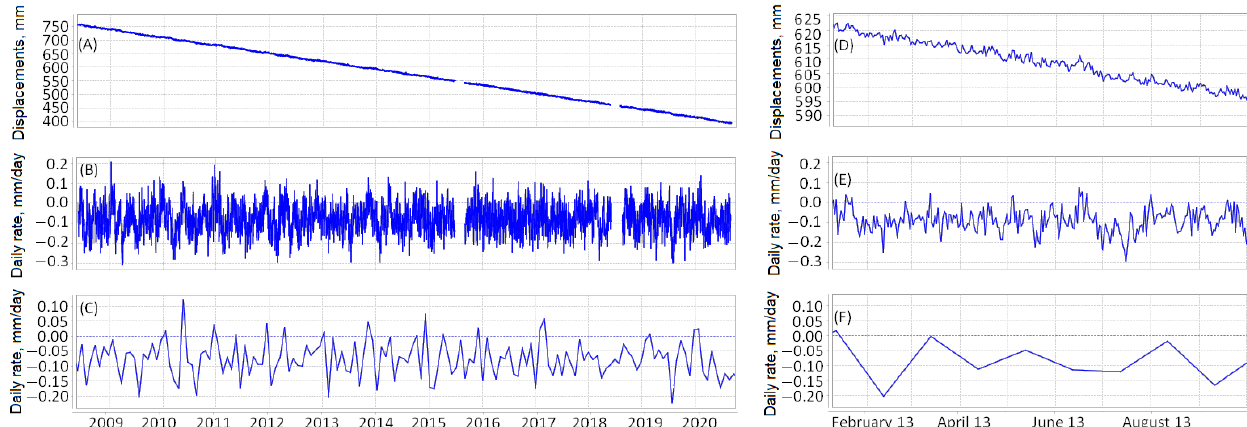
Figure 6. Time series of displacements in the W–E direction of the Californian receiving station at 39.49 ◦ N and 123.2 ◦ W. ( Left ) Interval 1 January 2008–14 November 2020. ( Right ) Interval 1 January 2013–1 October 2013. ( A , D ) time series of coordinates x ( t ) of the station (mm); ( B , E ) time series of daily rates g xk ( t ) of the station (mm/day); ( C , F ) time series V xn ( t ) at the point n of the field V x (mm/day).